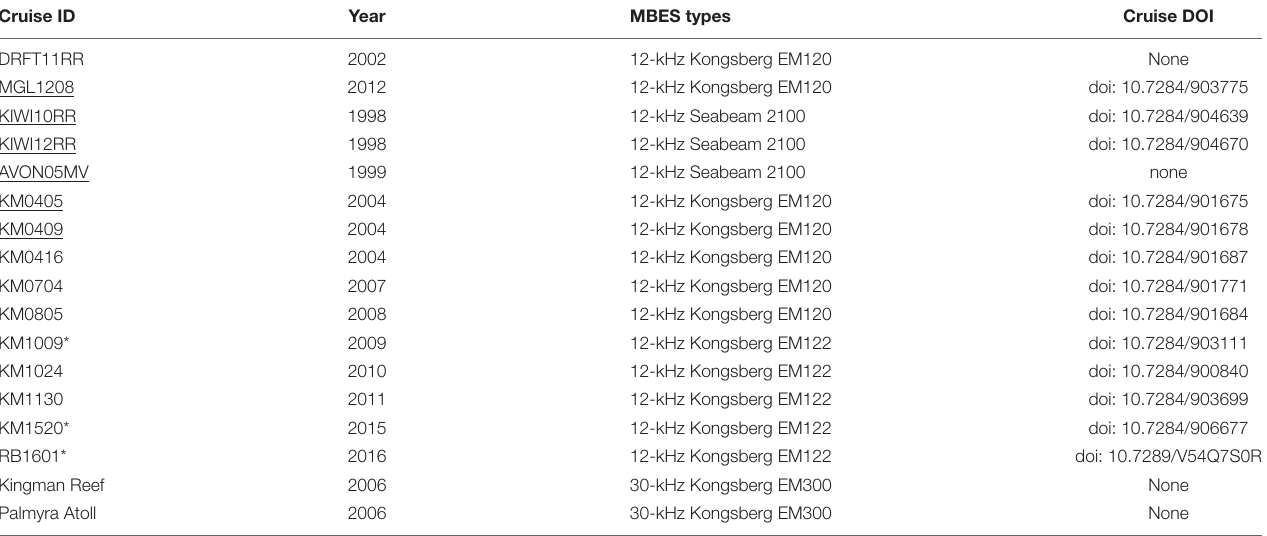
TABLE 1 | Multibeam echosounder cruises used in the bathymetry compilation. Cruise ID Year MBES types Cruise